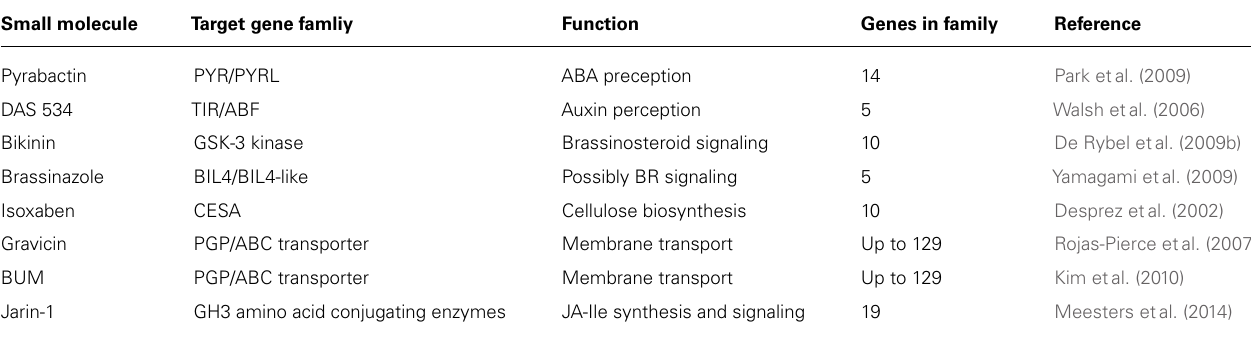
Table 1 | Published small molecules with identified targets within gene families. Small